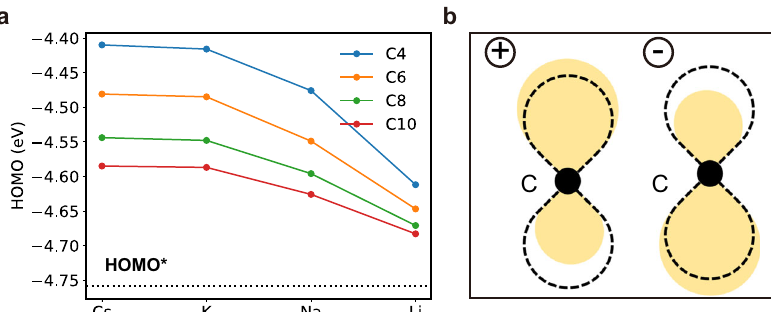
Fig. 4 Dependence of HOMO on alkyl chain length and counter ion. a The HOMO level of CPEs (with CPDT-BT backbone and COO ionic group) as a function of alkyl chain length (C4, C6, C8, C10) and counter ion (Li, Na, K Cs). The dashed horizontal line is the HOMO level of corresponding CPE* (CPDT-BT). b Schematic picture illustrating the polarization of a π -orbital on the backbone due to the presence of anionic group or a counter ion 28 . The yellow lopes indicate the π -electron distribution and the dashed contour represents the original π -orbital before the polarization. The positive and negative ions are shown by + and –